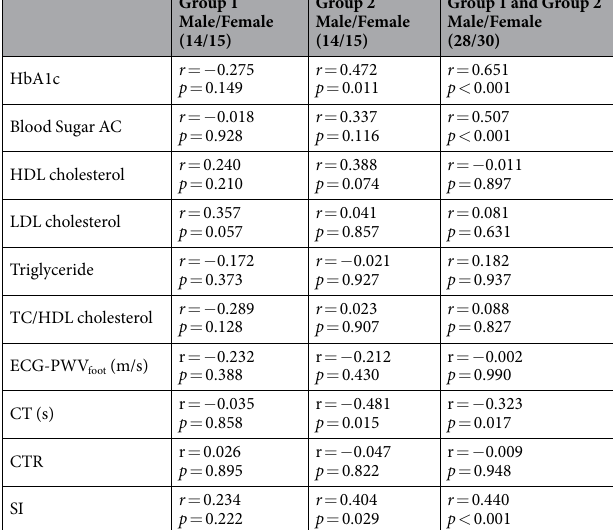
Table 2. Correlations between instantaneous frequency of maximal energy (f Emax ) and risk factors of atherosclerosis in healthy and diabetic subjects. Group 1 = Healthy upper middle-aged subjects, Group 2 = Patients with diabetes mellitus type 2; HbA1c = Glycated hemoglobin; Blood sugar AC = Fasting blood sugar; HDL = High density lipoprotein; LDL = Low density lipoprotein; TC = Triglyceride; ECG-PWV foot = Electrocardiography-pulse wave velocity of foot; CT = Crest time; CTR = Crest time ratio; SI = Stiffness index. * p < 0.05 Group 1 vs. Group 2, ** p < 0.001 Group 1 vs. Group 2. Significance of association determined by Pearson correlation